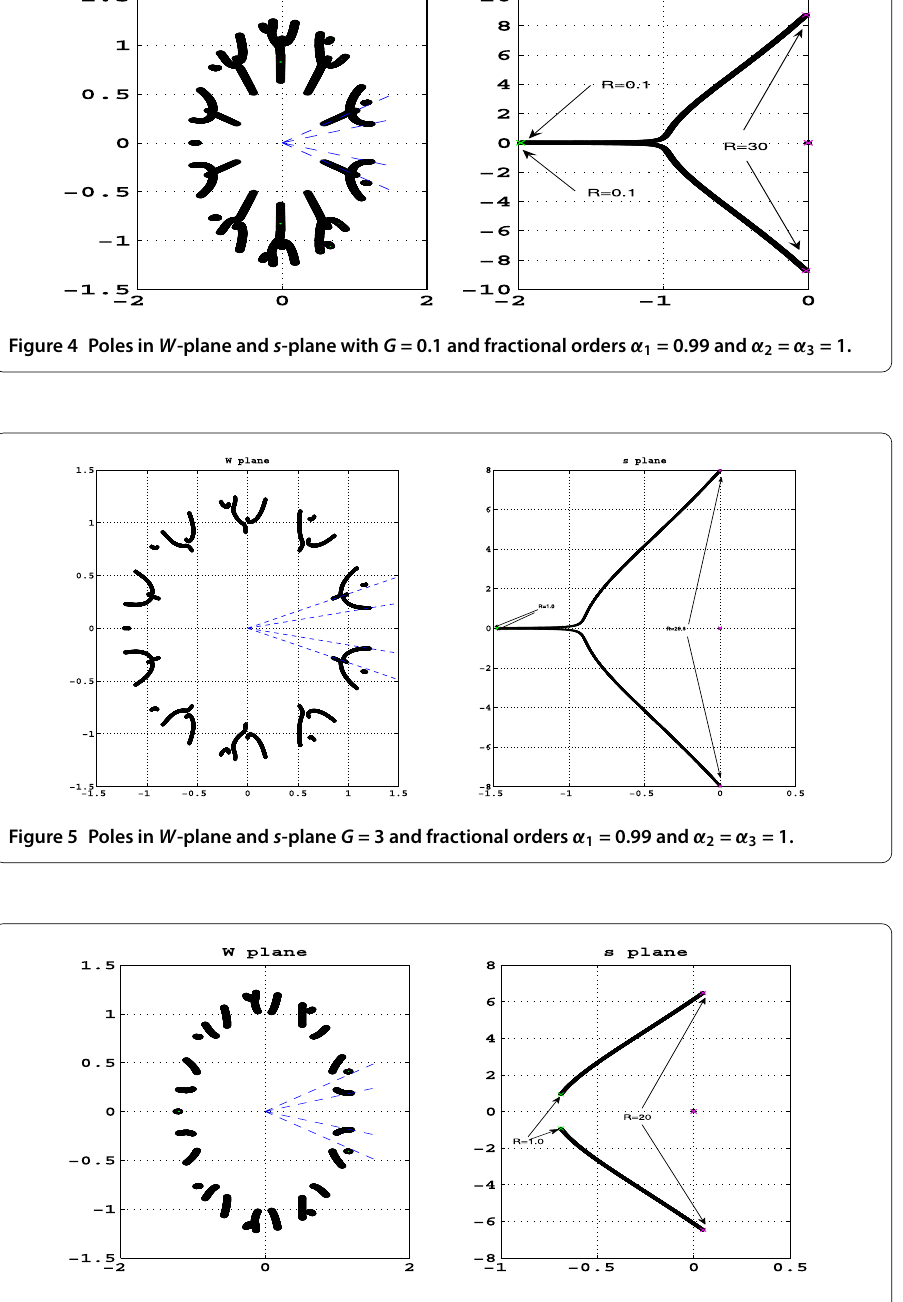
shows chaotic behavior for  ≤ τ ≤ ., and when τ is increased further, the system tends to periodicity ( τ = .) and becomes stable when τ = .. Figure  shows the effect of the fractional order α  = ., α  = α  =  for system ()-() with different values of Rayleigh number R and without time delay ( τ = ). It is clear that the chaotic solution takes over and the convection loses its stability when R increases from  to . For